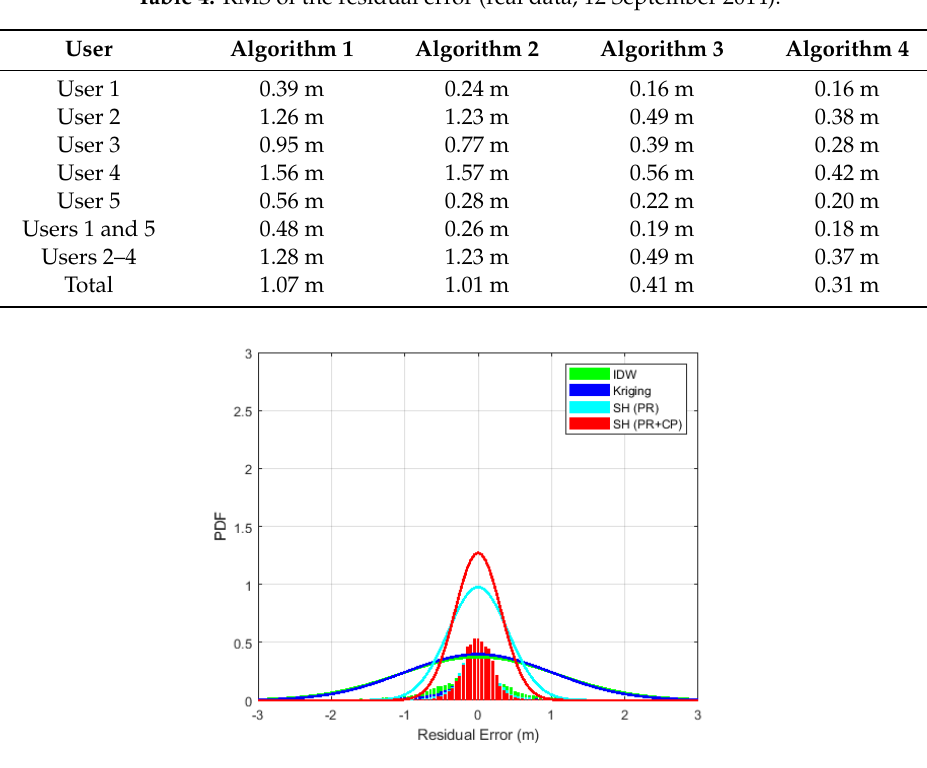
Table 4. RMS of the residual error (real data, 12 September 2014).